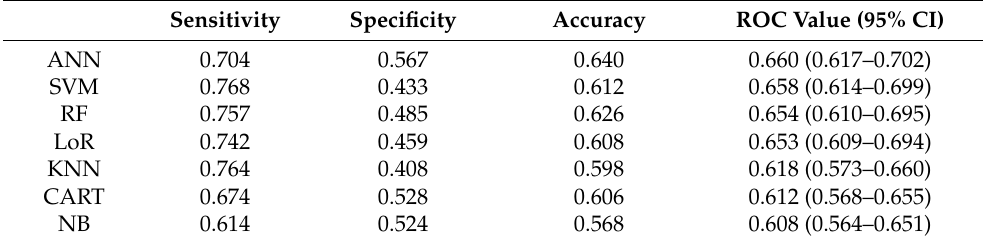
Table 2. Performance of different machine learning models for prediction of smoking cessation